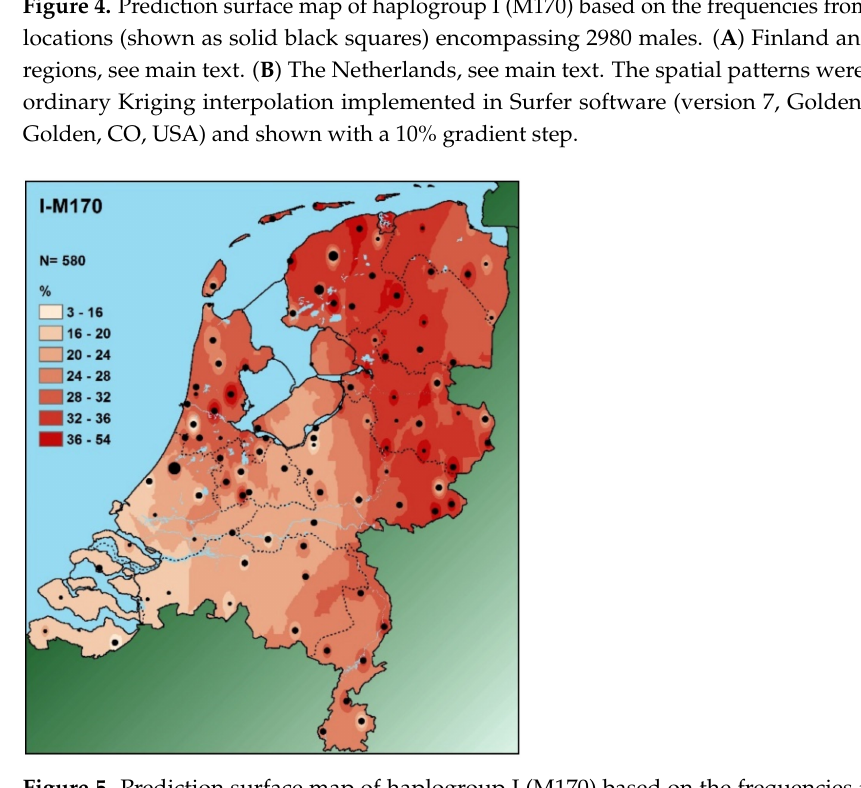
Figure 5. Prediction surface map of haplogroup I (M170) based on the frequencies from 99 Dutch locations (shown as solid black circles) encompassing 2085 males [83]. The spatial patterns were created using ordinary Kriging interpolation implemented in ArcGIS version 10.2 with the Spatial Analyst